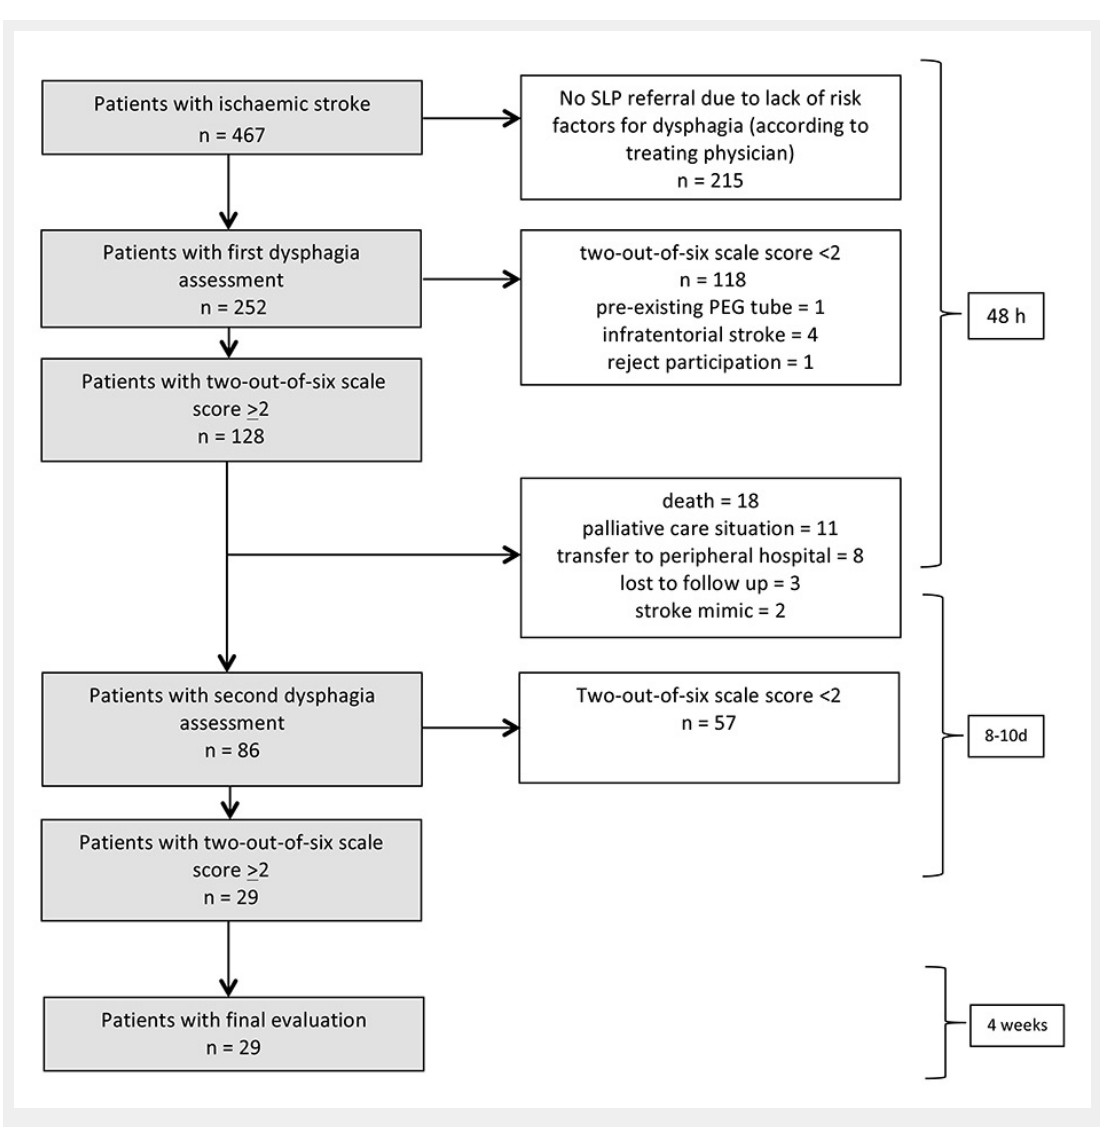
Patient enrolment and exclusion. First and second dysphagia assessments consisted of: comprehensive dysphagia assessment including the two-out-of-six scale. If the two-out- of-six scale score was ≥2 the Parramatta Hospitals’ Assessment of Dysphagia was added by a speech-language pathologists (SLP) who was unaware of the other dysphagia and clinical assessments. First assessment was performed within 48 h after stroke onset and the second 8–10 d after stroke onset. The final evaluation was performed by an SLP blinded to clinical follow up and consisted of a telephonic interview with assessment of the BODS-2 scale (Bogenhausen-dysphagia-score, part 2) 4 weeks after the second assessment (5–7 weeks after stroke